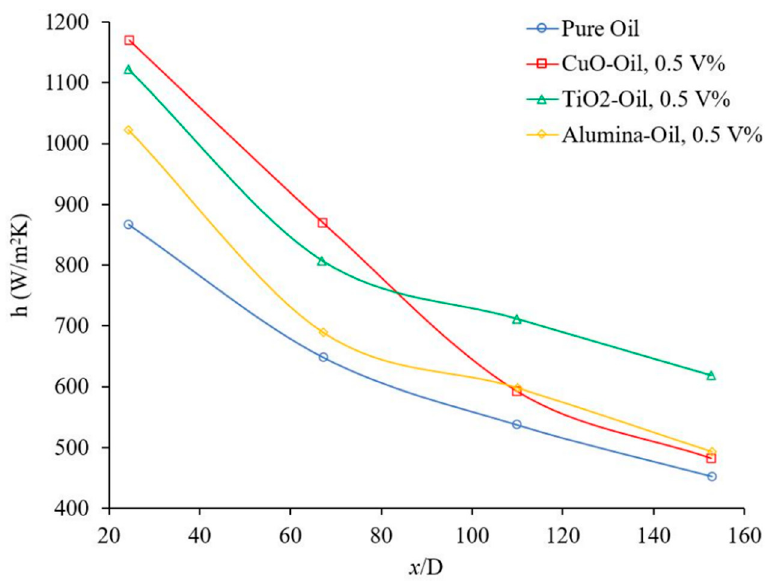
Figure 8. Effect of nanoparticle material on heat transfer coefficient at Re ≈ 750, Heris et al.